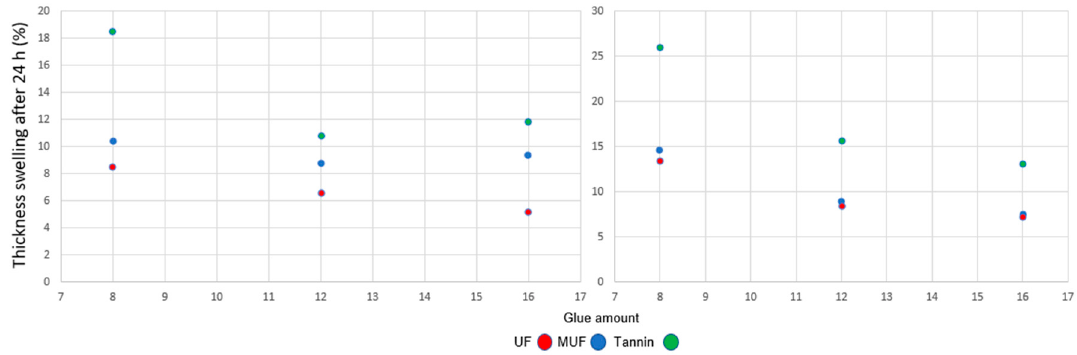
Figure 6. Thickness swelling after 24 h at three levels of glue amount for 300 kg / m 3 ( left ) and 500 kg / m 3 ( right ).